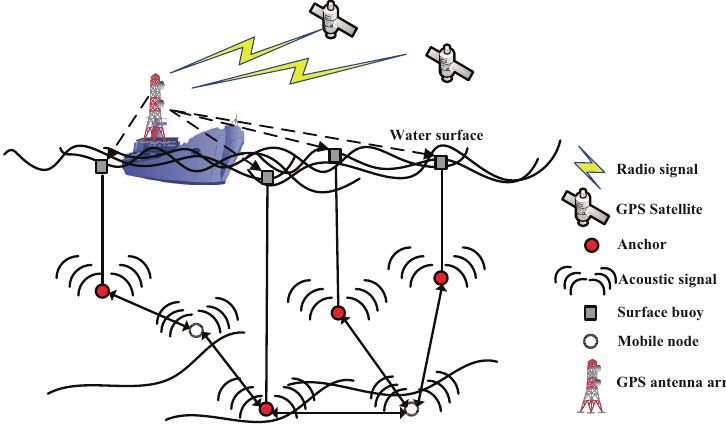
Figure 1. Underwater acoustic sensor networks